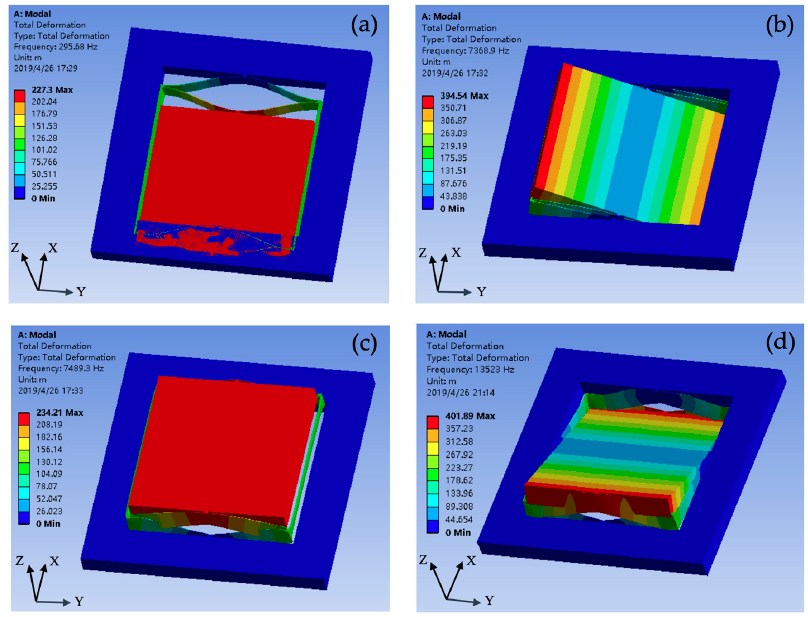
Figure 3. Finite element analysis (FEA) simulation results of the eigenmode: ( a ) fundamental translational mode X; ( b ) rotational mode 𝛼 about X -axis; ( c ) translational mode Z; ( d ) rotational mode 𝛽 about Y -axis.